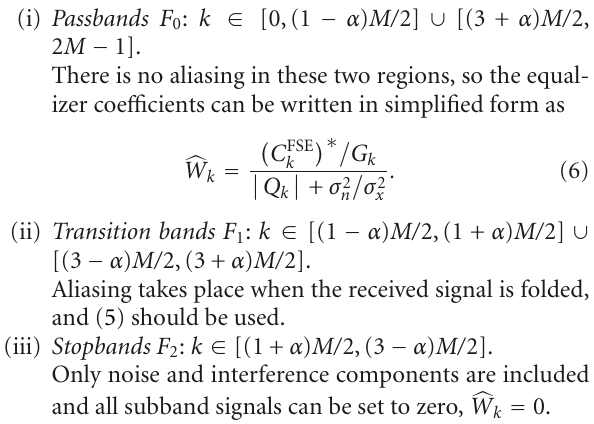
place in an optimal manner. The performance is expected to approach the performance of an ideal linear